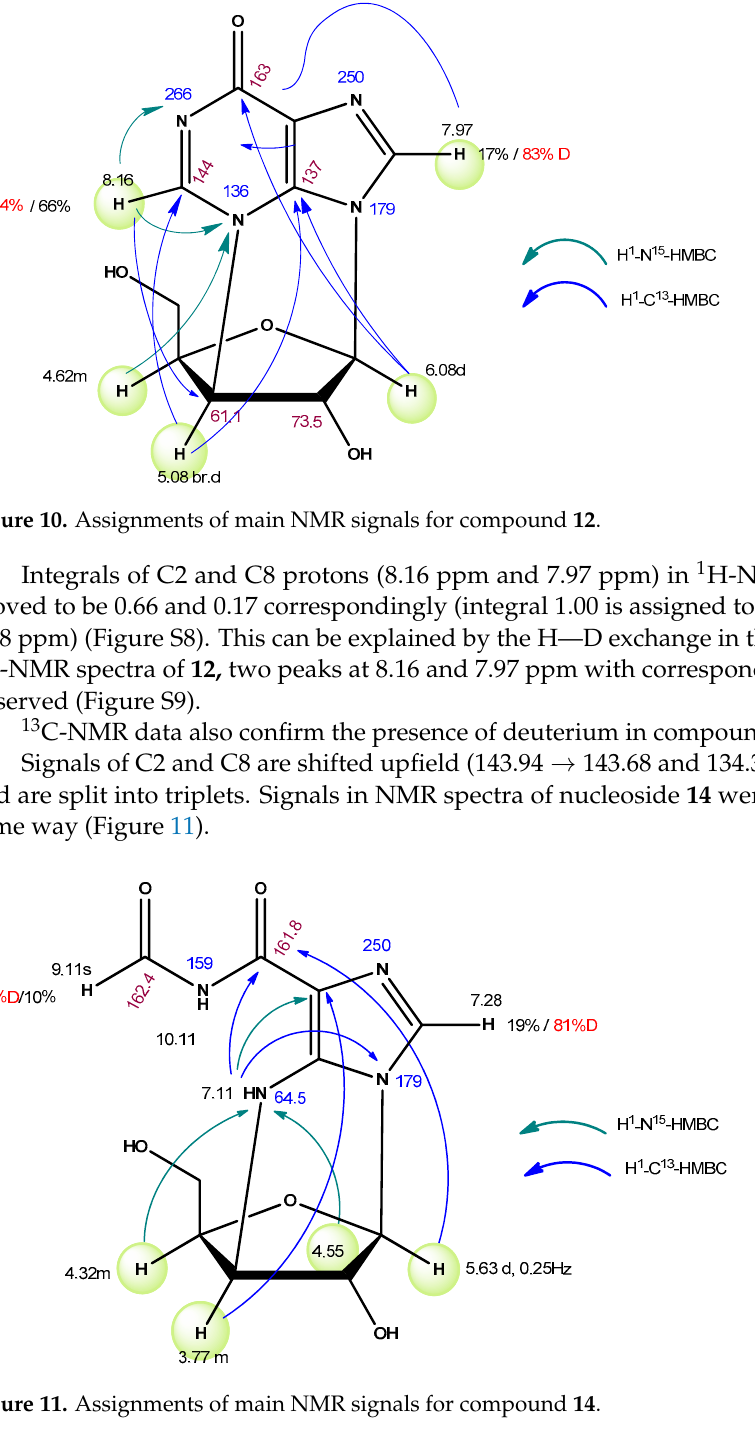
Figure 9. The UV spectra of reaction mixtures obtained during hydrolysis of 14 (D 2 O, ap- peared pH 4.1).